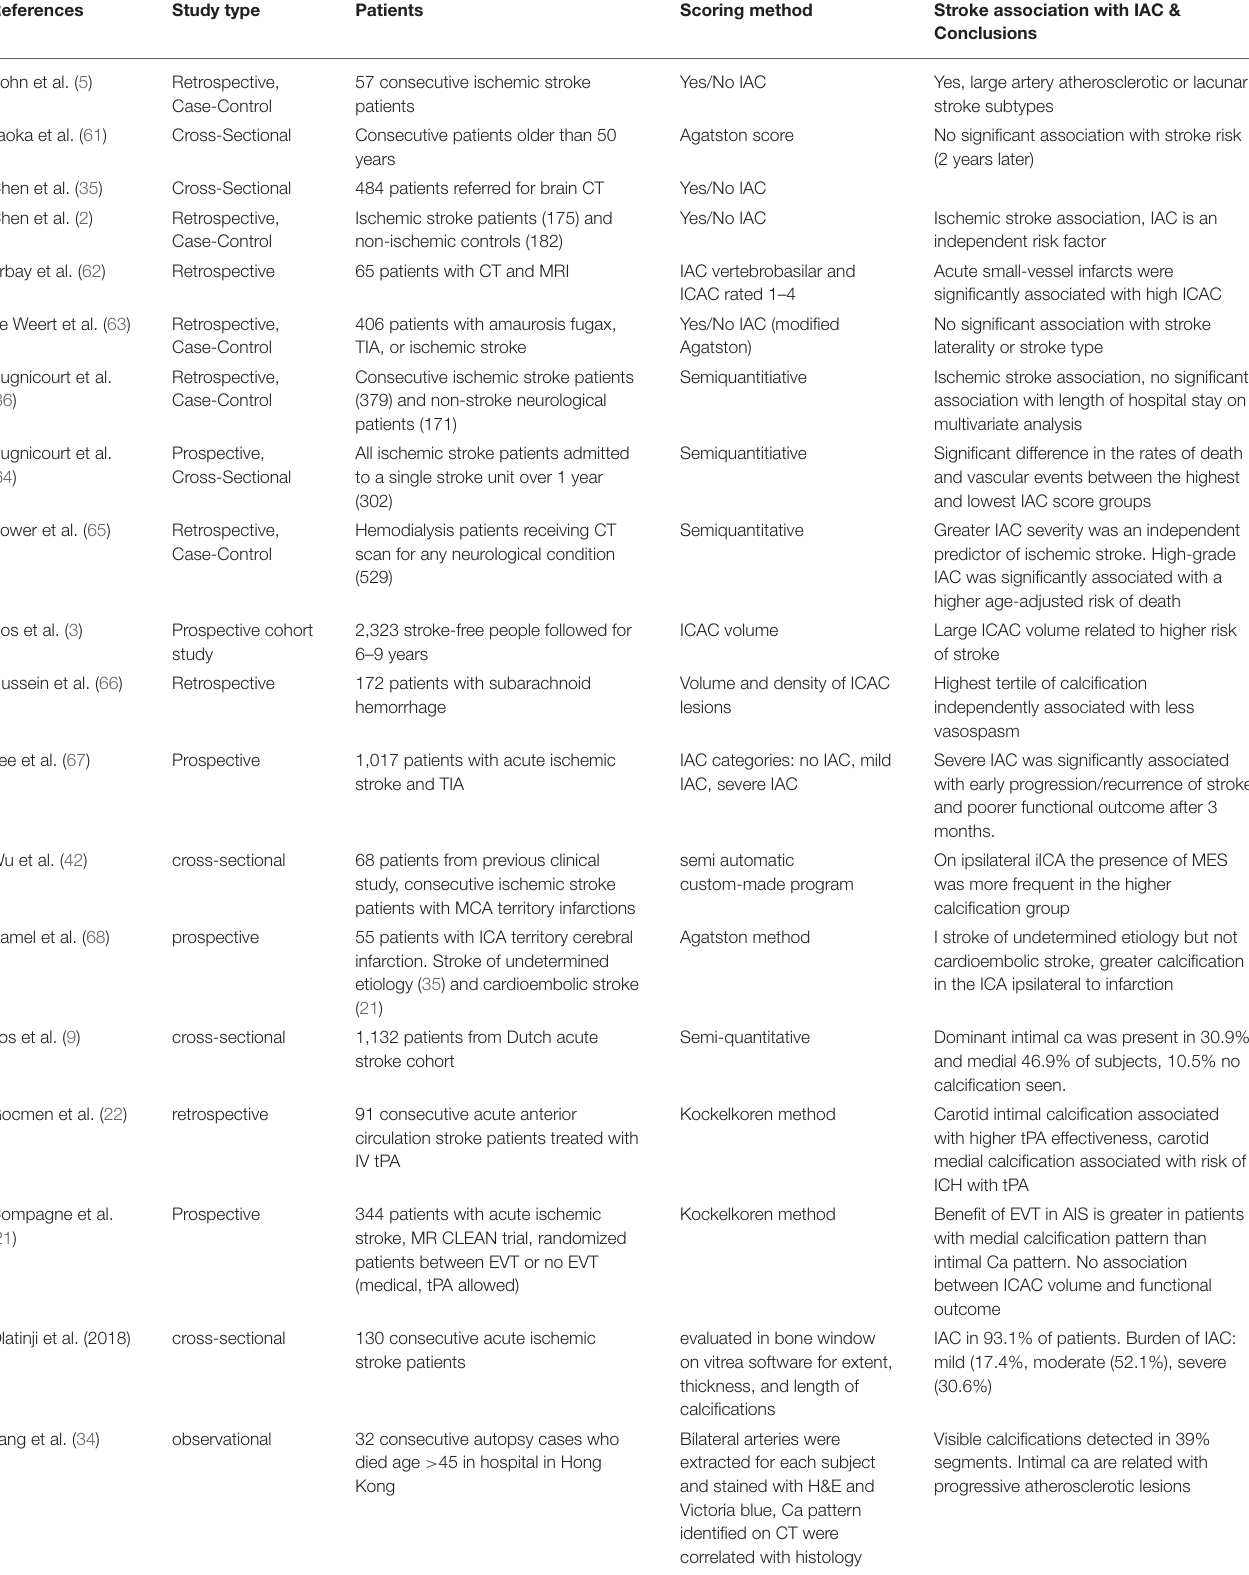
TABLE 2 | Intracranial arterial calcification and stroke